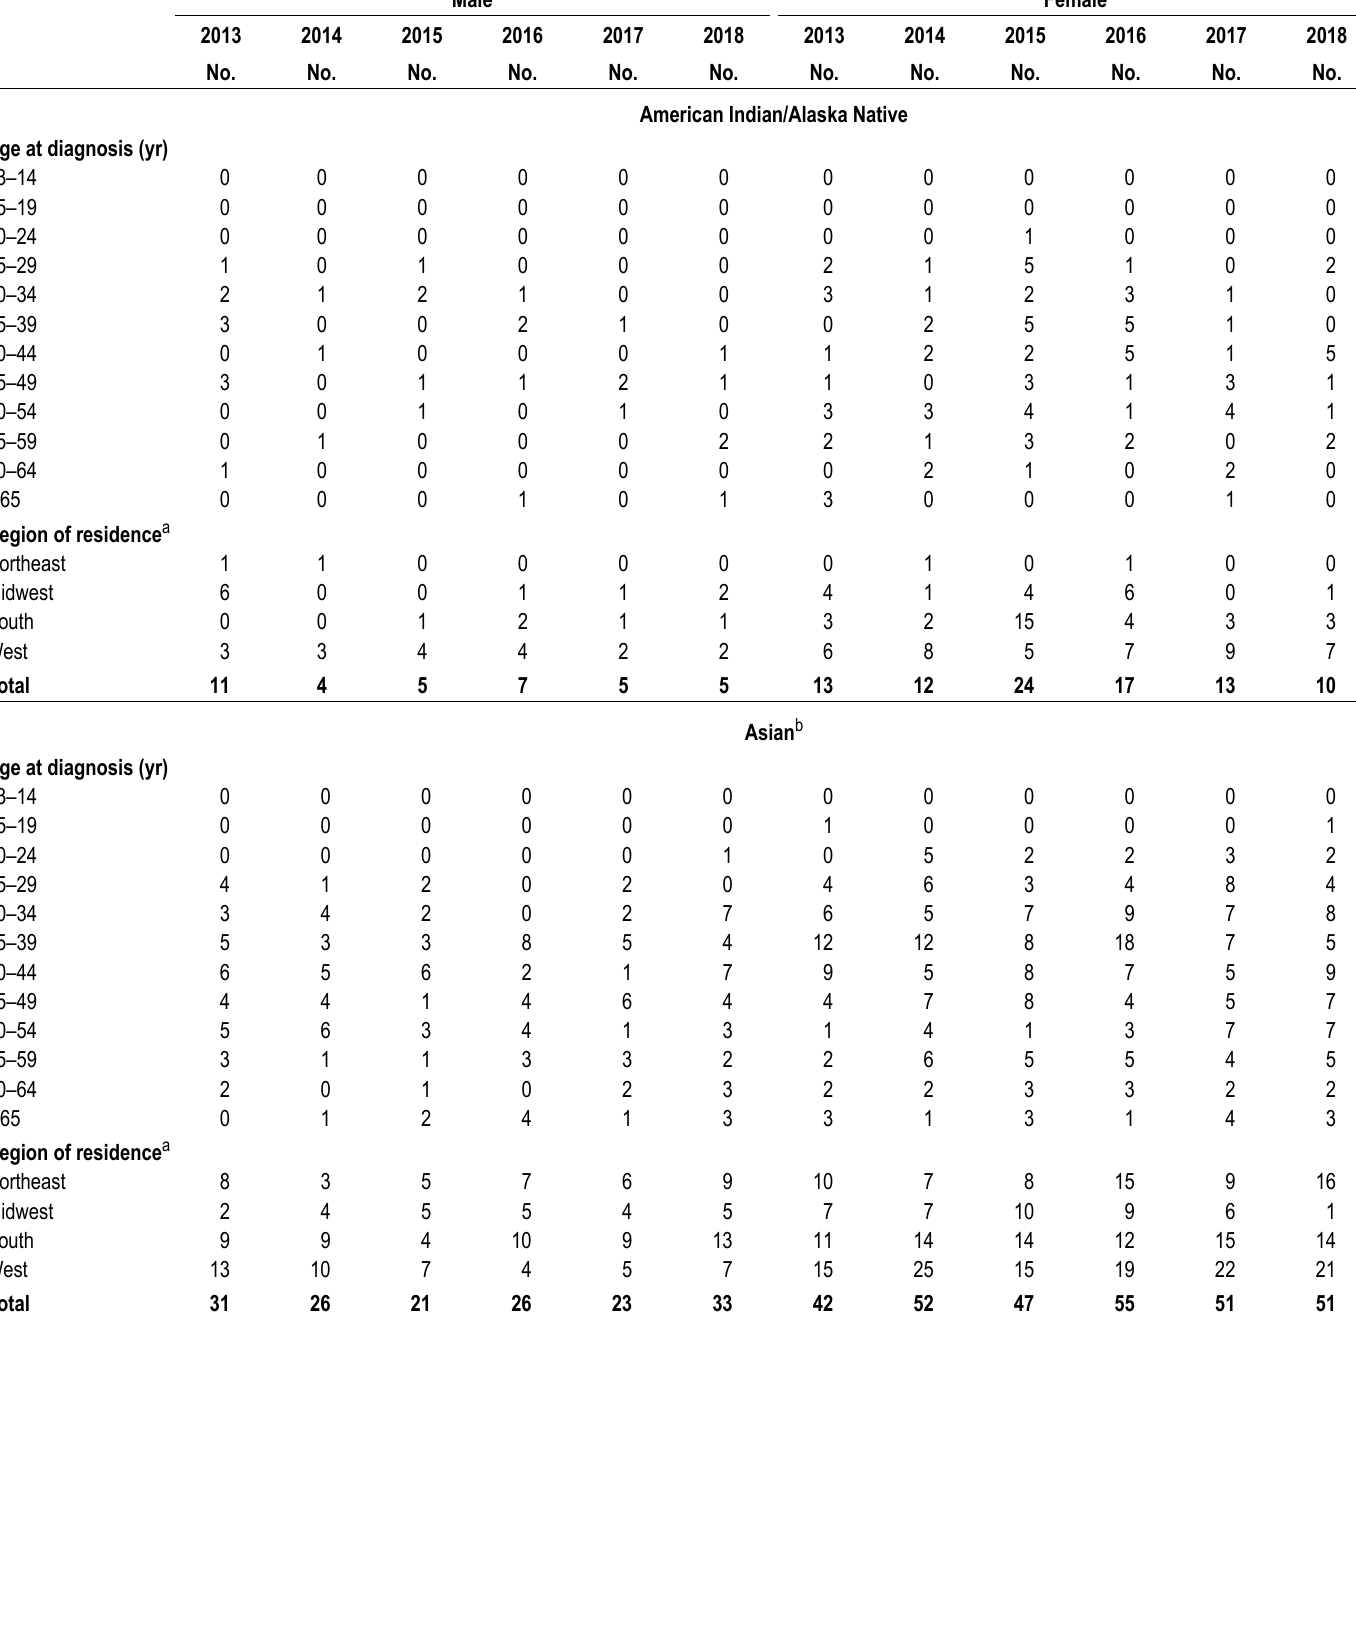
Table 12a. Stage 3 (AIDS) attributed to heterosexual contact, by selected characteristics, 2013–2018—United States